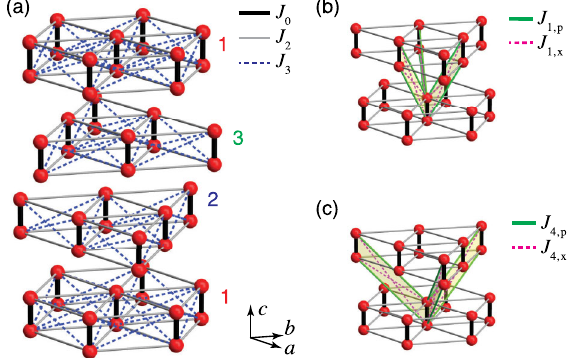
FIG. 2 (a) Magnetic (Mn 5 þ ) lattice of Ba 3 Mn 2 O 8 . (b) and (c) NN and next-NN exchange couplings between adjacent